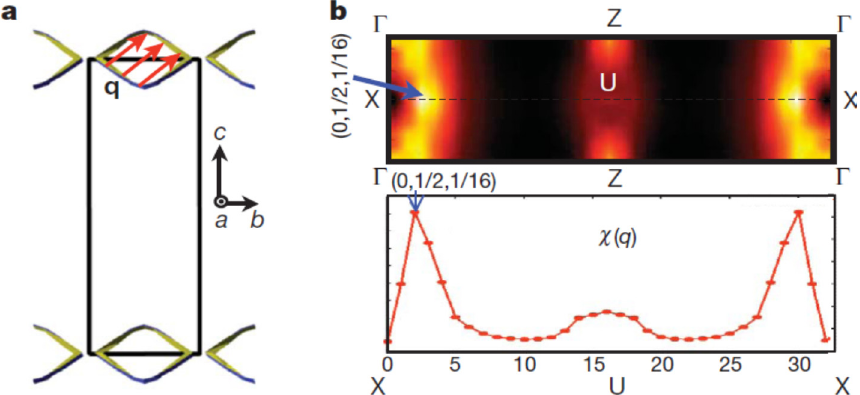
Figure 8. Fermi surface and generalized electron susceptibility (cid:2031)(cid:4666)(cid:1869)(cid:4667) of In 4 Se 3 −δ ( δ = 0.25). ( a ) Fermi surface of In 4 Se 3 −δ ( δ = 0.25) in the bc -plane (blue and green lines). Black square is the first Brillouin zone. Fermi nesting vector (cid:1869) (red arrow) is defined in the closed Fermi surface. ( b ) Generalized electron susceptibility (cid:2031)(cid:4666)(cid:1869)(cid:4667) along the X(0, 1/2, 0)–U(0, 1/2, 1/2) symmetry line (top). Reproduced with permission from Nature publishing Group, 2009